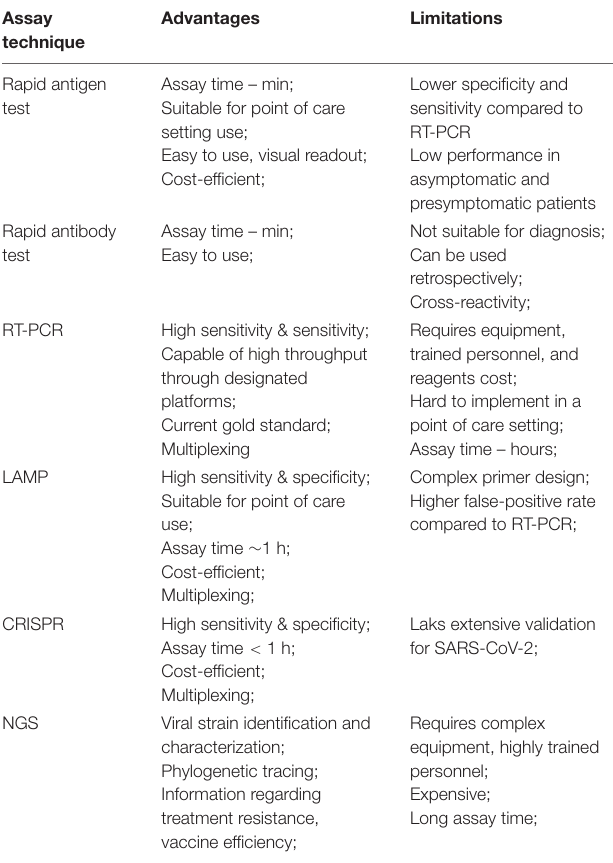
TABLE 2 | SARS-CoV-2 diagnostic assays advantages and limitations. Assay Advantages technique